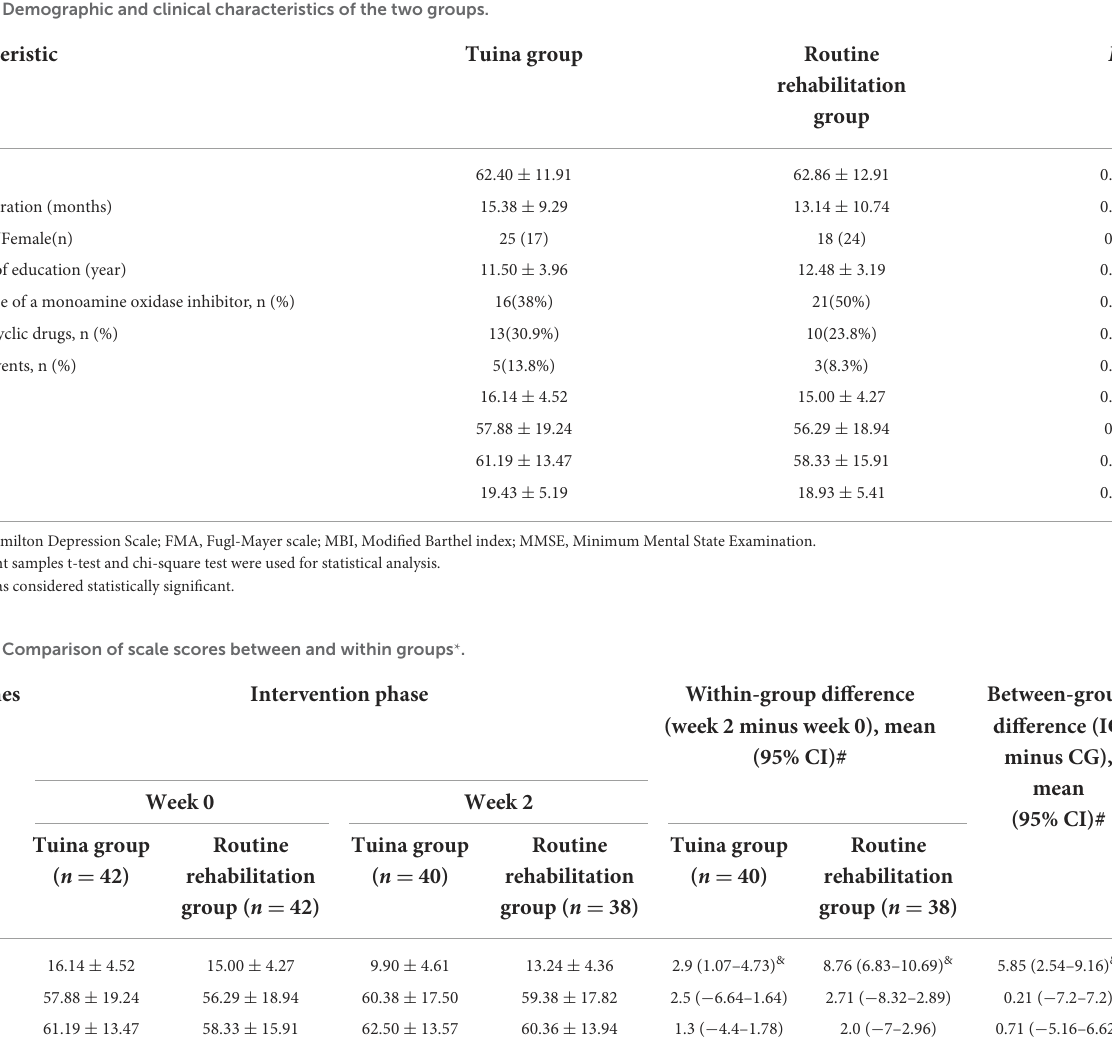
TABLE 1 Demographic and clinical characteristics of the two groups.